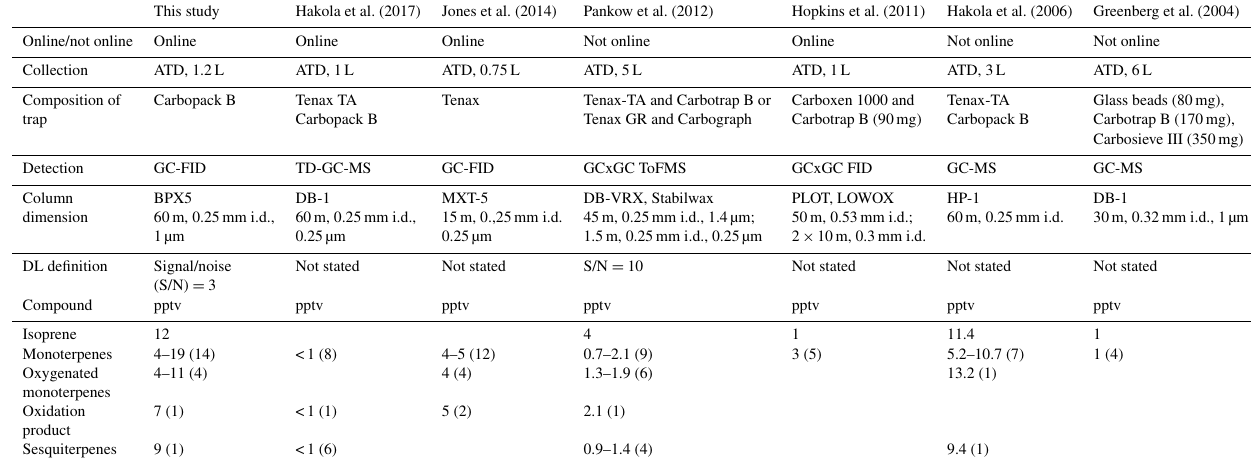
Table 1. Comparison of the operation conditions (sampling method, detector, and column used) and the limit of detection (DL). For the compounds, the DL is given and the number of species follows in